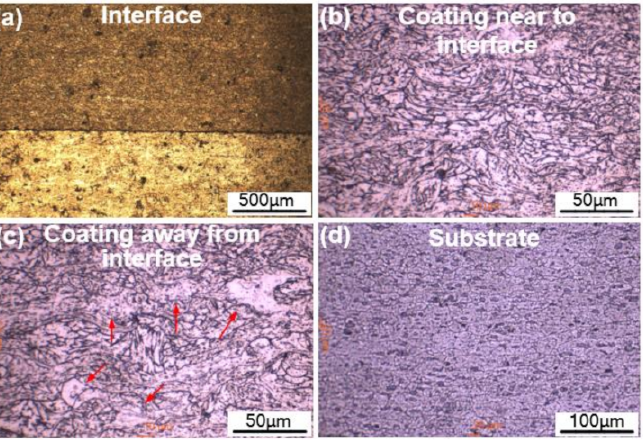
Figure 2. Microstructures of the sample #0 without laser assisting. ( a ) Interface; ( b ) coating near to interface; ( c ) coating away from interface; ( d )